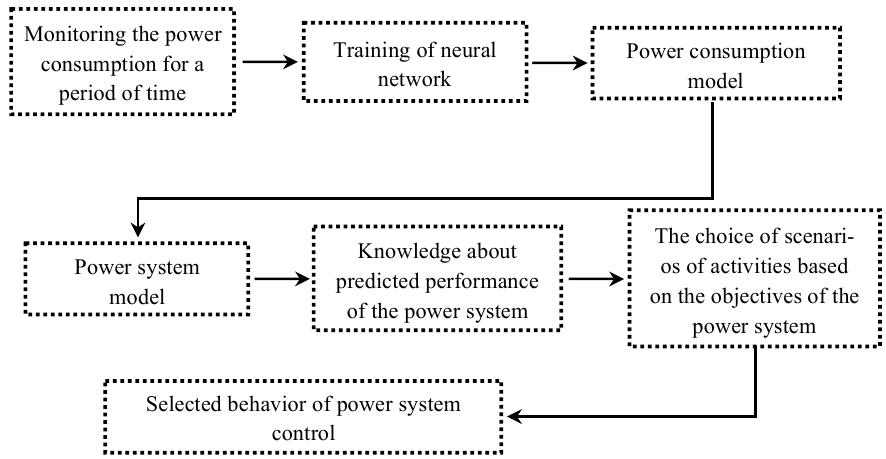
Fig. 9. Using a forecast about power consumption for choosing the behavior of power system